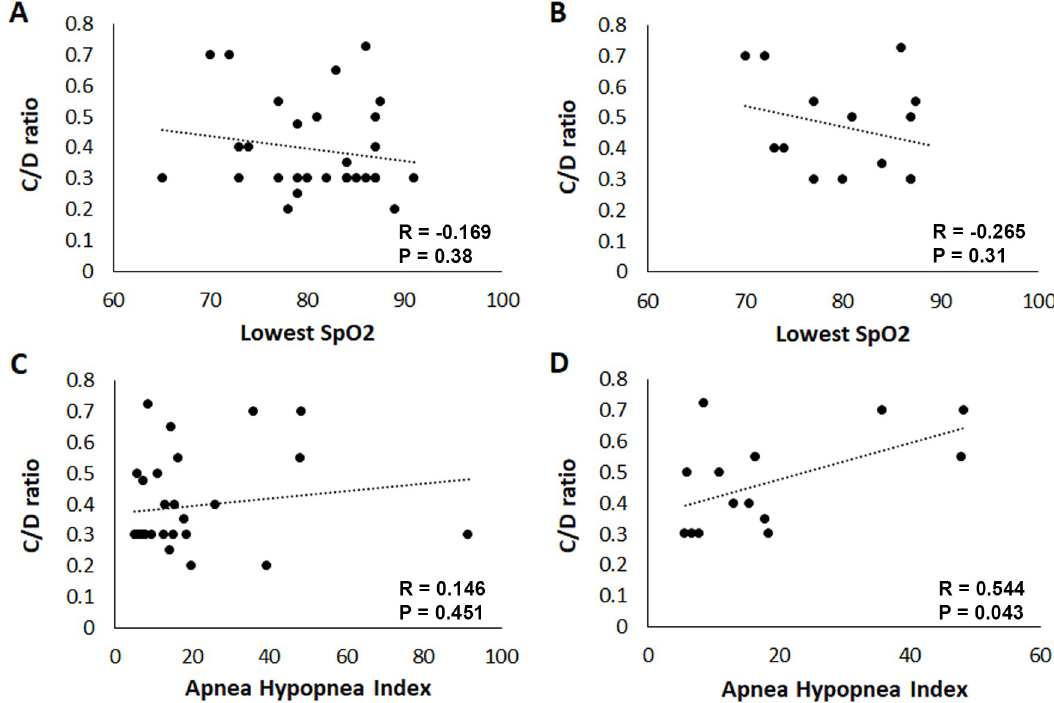
Fig 4. The relationship between OSA parameters and cup-to-disc ratio. (A) There was no correlation between the lowest SpO2 value and the cup-to-disc ratio for all patients in the OSA group (N = 36, R = -0.169, P = 0.38). (B) Similarly, there was no correlation between the lowest SpO2 value and the cup-to-disc ratio for patients that were referred for a glaucoma evaluation (N = 15, R = -0.265, P = 0.31). (C) There was no correlation between the apnea hypopnea index and the cup-to-disc ratio in all patients in the OSA group (N = 36, R = 0.146, P = 0.451). (D) There was a significant positive correlation between the apnea hypopnea index and the cup-to-disc ratio for patients that were referred for a glaucoma evaluation (N = 15, R = 0.546, P =